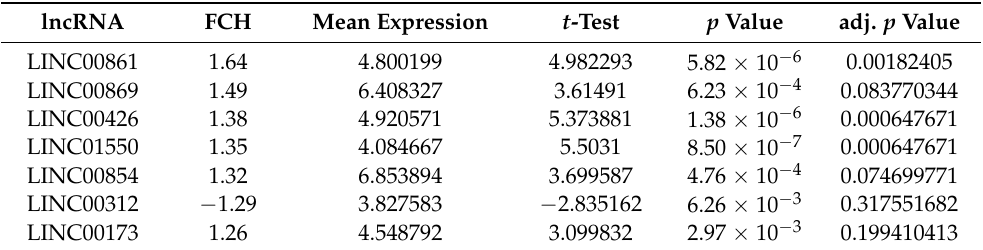
Table 3. Summary statistics from a linear model to determine long non-coding RNAs differential expression in IM vs. non-IM samples.